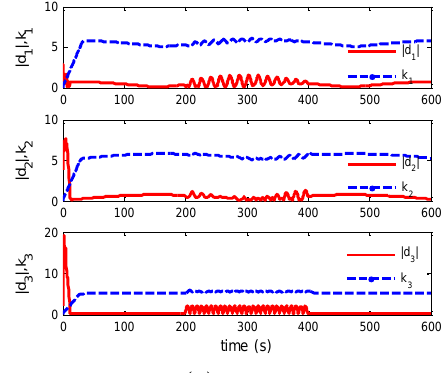
Figure 7. Gain   k t and unknown terms d(t).